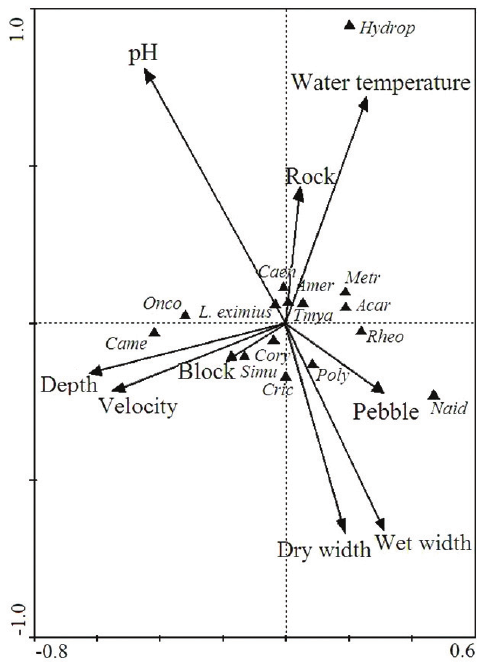
Figure 8. CCA ordination of drifting taxa and abiotic vari-